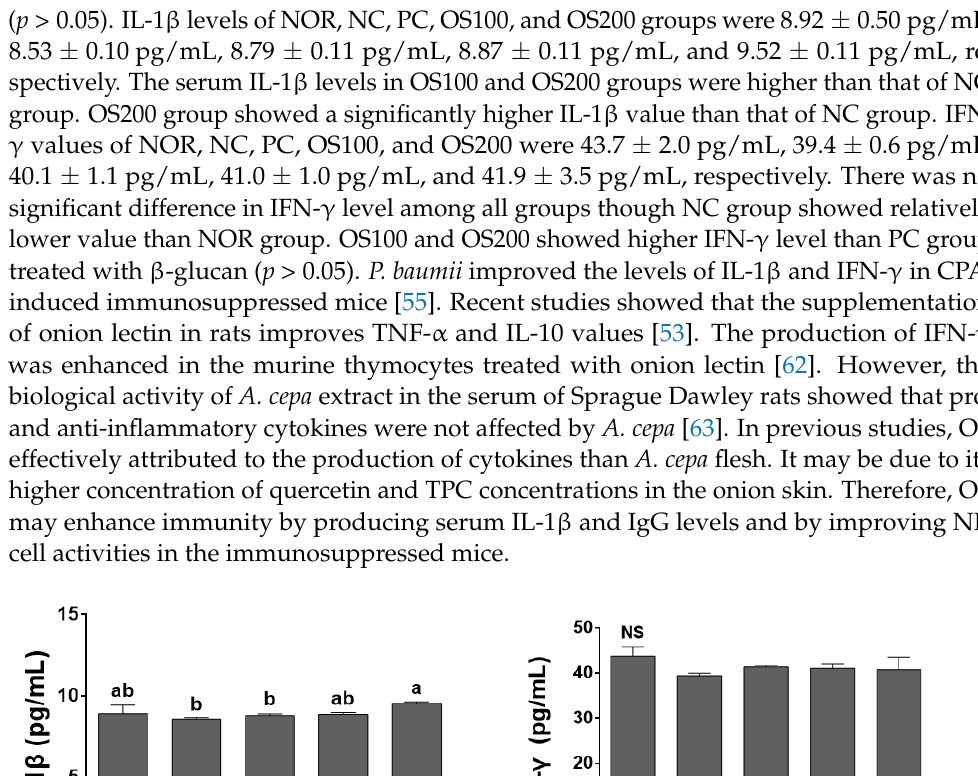
( b ) Figure 9. Effects of A. cepa skin (OS) extracts on the proliferation of splenocytes treated with ( a ) Con A and ( b ) LPS in the C57BL/6 mice immunosuppressed by cyclophosphamide (CPA). NOR, normal control group; NC, negative control group; PC, positive control group; OS100, OS extract 100 mg/kg BW; OS200, OS extract 200 mg/kg BW. Data was expressed as the mean ± SEM. a–d Different letters are significantly different at p < 0.05.